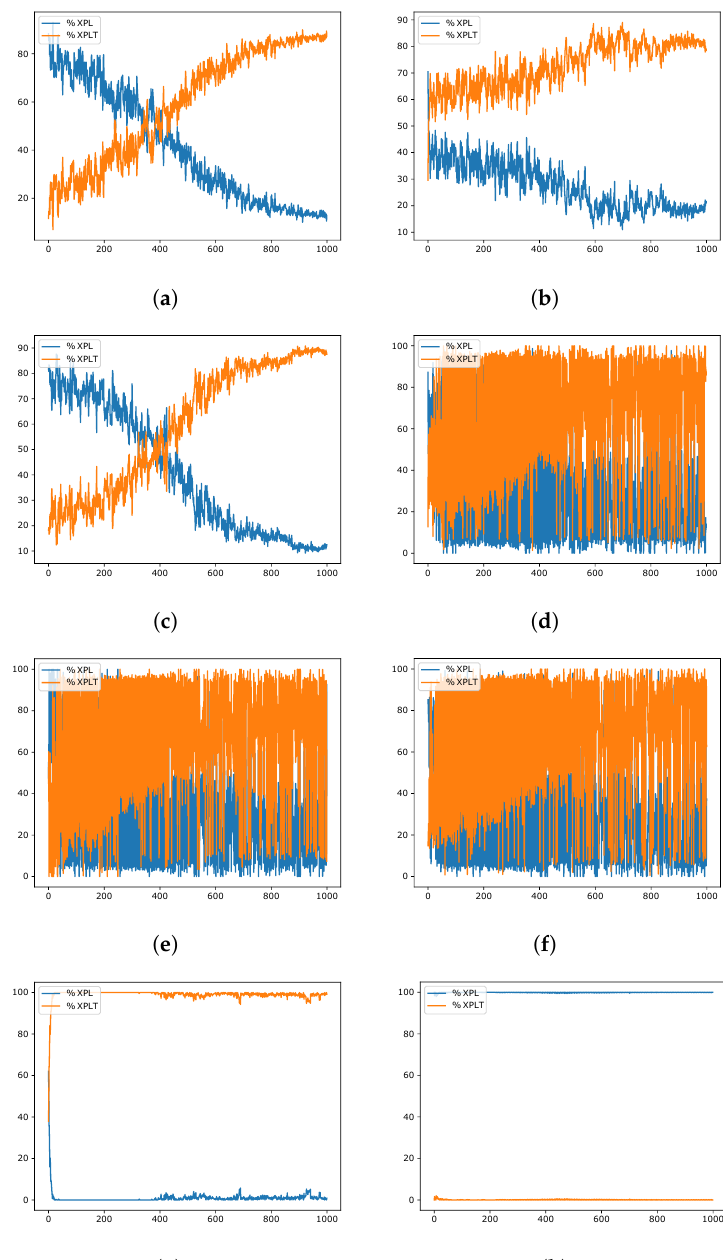
Figure 10. WOA instances exploration–exploitation percentages when resolving the scp41 instance of the SCP. Instance Optimum: 429. ( a ) 80aBQSA—fitness obtained 430; ( b ) 80aQL—fitness obtained 431; ( c ) 80aSA—fitness obtained 430; ( d ) 40aBQSA—fitness obtained 430; ( e ) 40aQL—fitness obtained 430; ( f ) 40aSA—fitness obtained 431; ( g ) BCL—fitness obtained 489; ( h ) MIR—fitness obtained